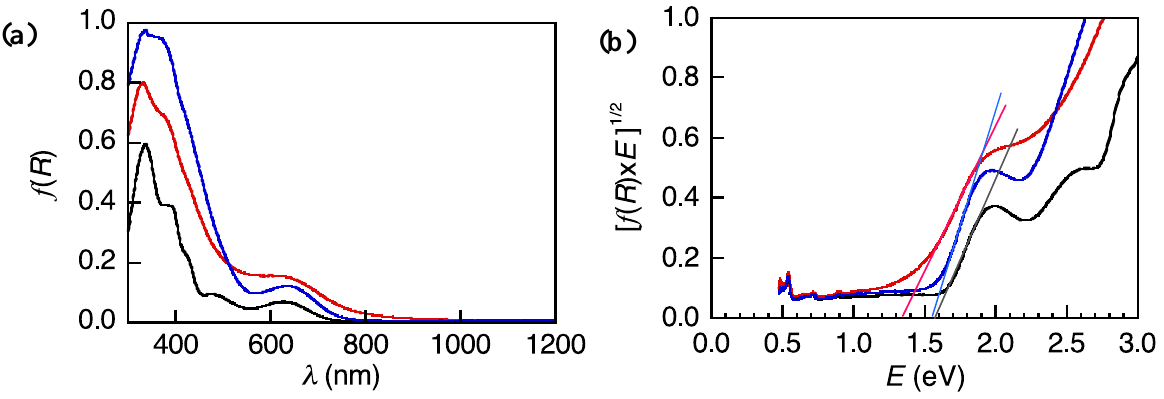
Figure 2. ( a ) Diffuse-reflection UV-Vis-NIR absorption spectra of mononuclear